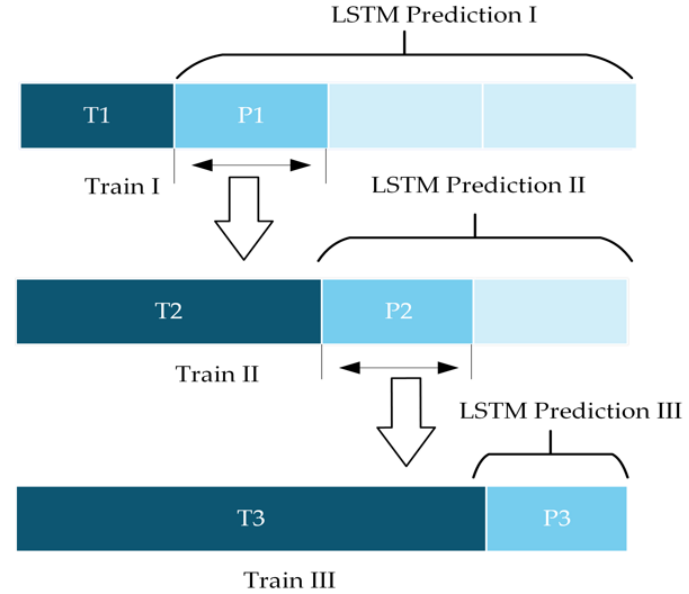
Figure 5. The segmented LSTM prediction flowchart.